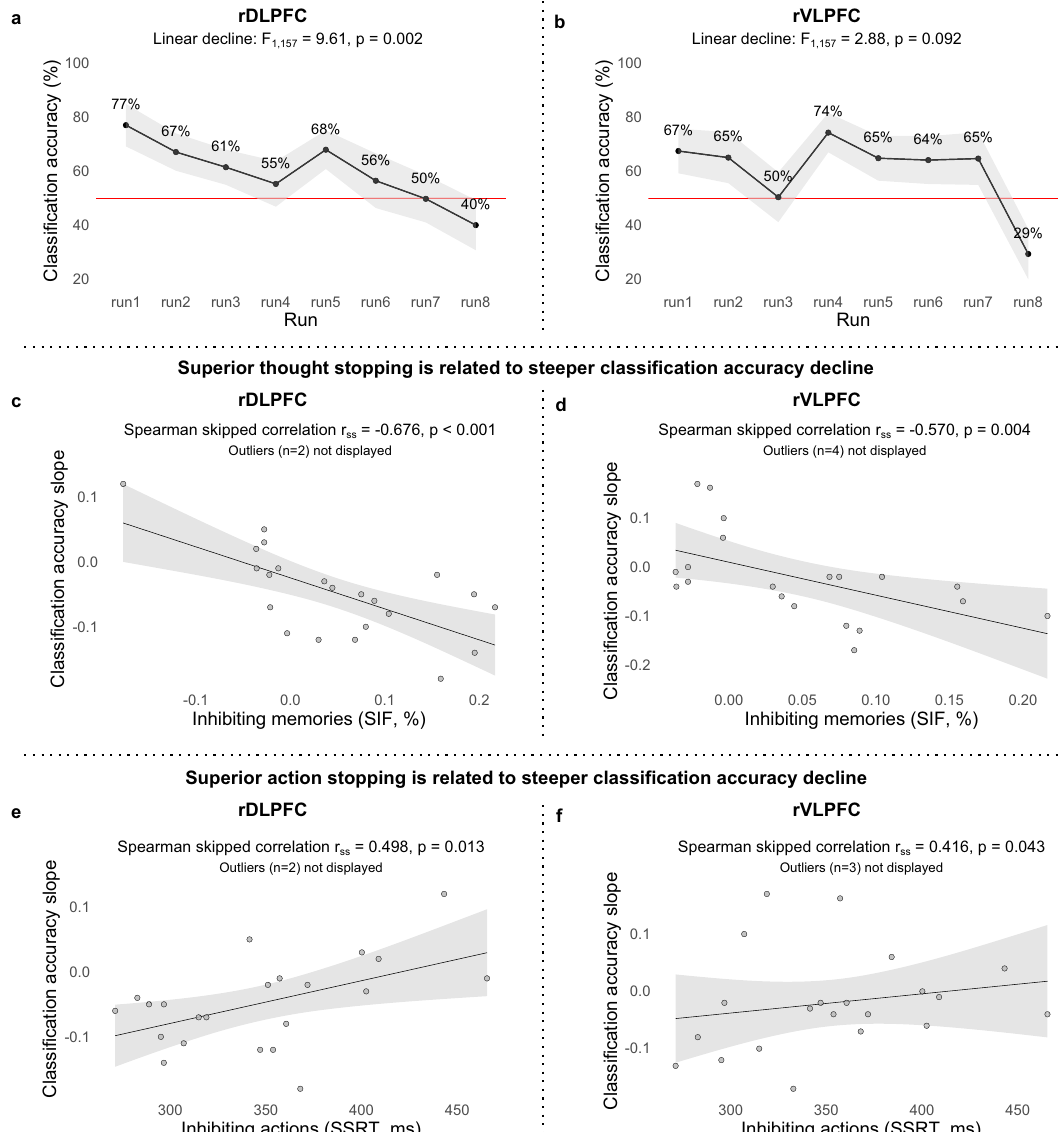
Fig. 6 Con fl ict-reduction bene fi t. a – f Sample size n = 24. Source data are provided as a Source Data fi le. a , b Accuracy of the action-stopping classi fi er (trained to distinguish Stop from Go conditions) to discriminate thought suppression (classifying No-Think as Stop) for each of the fMRI task runs in the rDLPFC and rVLPFC, respectively. Data are presented as mean values. Shading represents within-subject standard error. Linear decline was assessed by ANOVA linear contrast. c , d Correlation between the classi fi cation accuracy slope across the runs and suppression-induced-forgetting scores. Shading represents 95% CI. e , f Correlation between the classi fi cation accuracy slope across the runs and stop-signal reaction time. Shading represents 95%